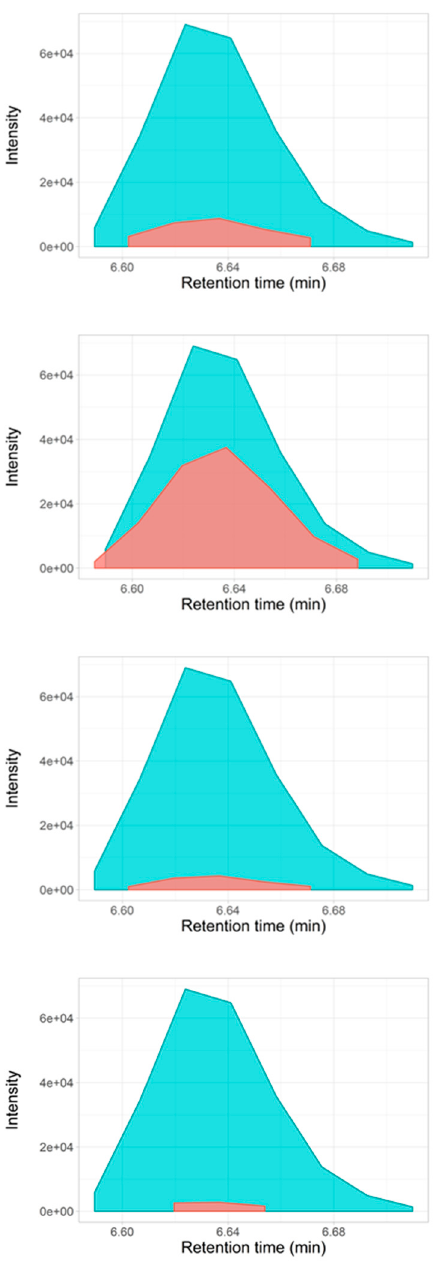
Figure 4. Extracted ion chromatograms (EIC) of phenylacetylglutamine precursor and fragment ions detected by LC-DIA-MS/MS at CE 20 eV generated with the ScoresDIA.R function. Figure shows coelution plots for each of the precursor-product pair ions from top to bottom: 84.0444 m/z , 130.0499 m/z , 136.0756 m/z , and 147.0763 m/z .